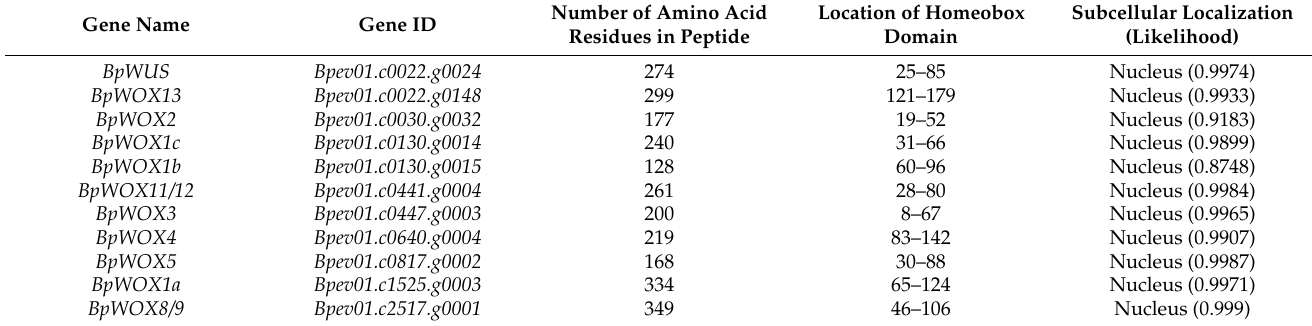
Table 4. The features of the B. pendula WUSCHEL-related homeobox (WOX) family